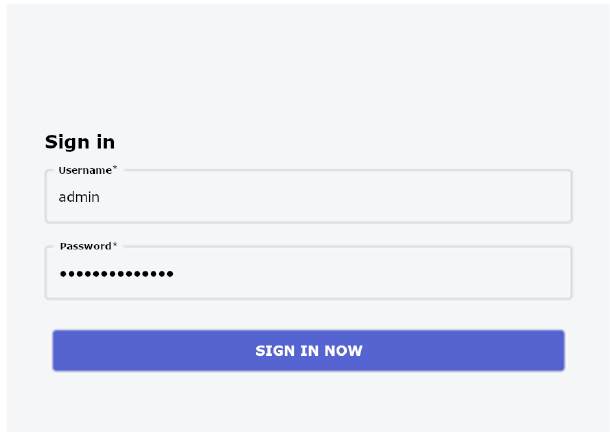
Figure 12. Login tab of the Front-end